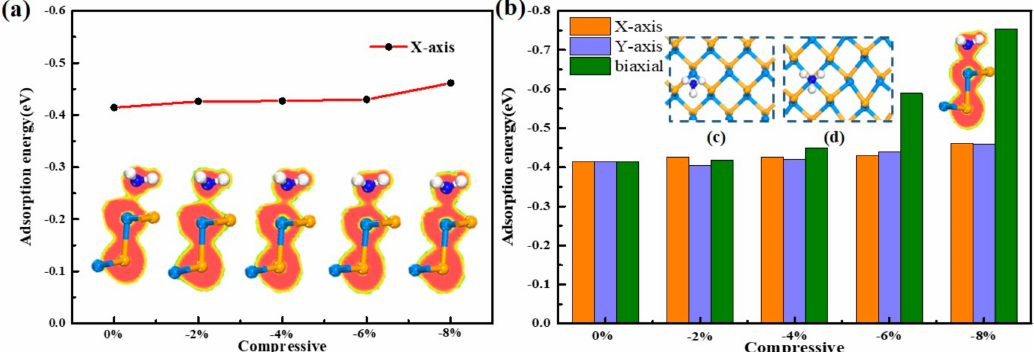
Figure 6. ( a ) The change curves of E ad with compressive strain from 0% to − 8% in NH 3 / strained-SiSe systems, ELF from left to right represents 0%, − 2%, − 4%, − 6%, and − 8% of stress. ( b ) The comparison of adsorption energy with X-axis, Y-axis, and biaxial under compressive strain from 0% to − 8% in NH 3 / strained-SiSe systems, the data is shown in Table S1. The inset of ( b ) represents the ELF of − 8% biaxial of NH 3 / SiSe monolayer. The inset is morphology of NH 3 system ( c ) without stress and ( d ) with − 8% stress in biaxial direction.